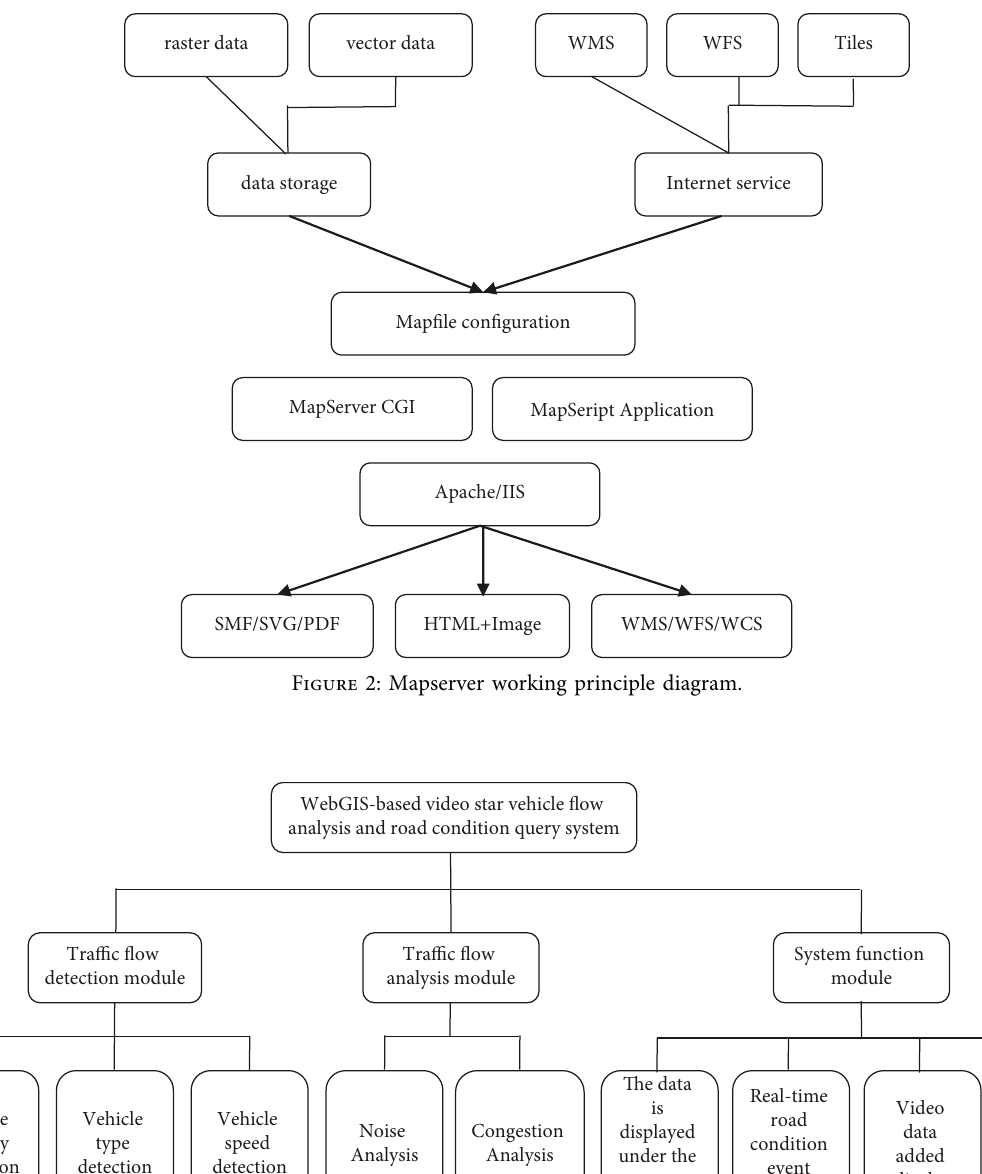
Figure 3: System function structure diagram.